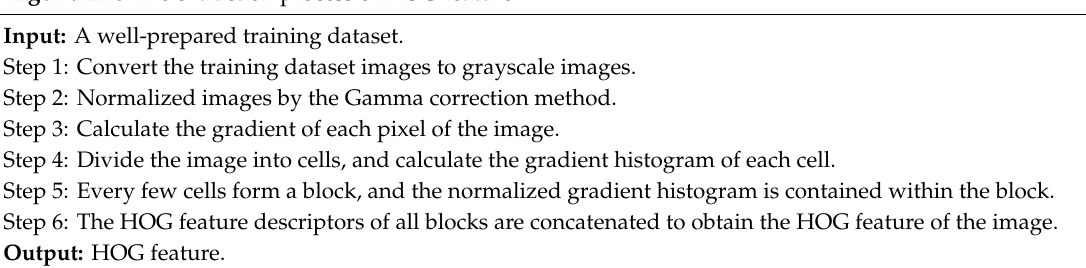
Algorithm 3 The extraction process of HOG feature